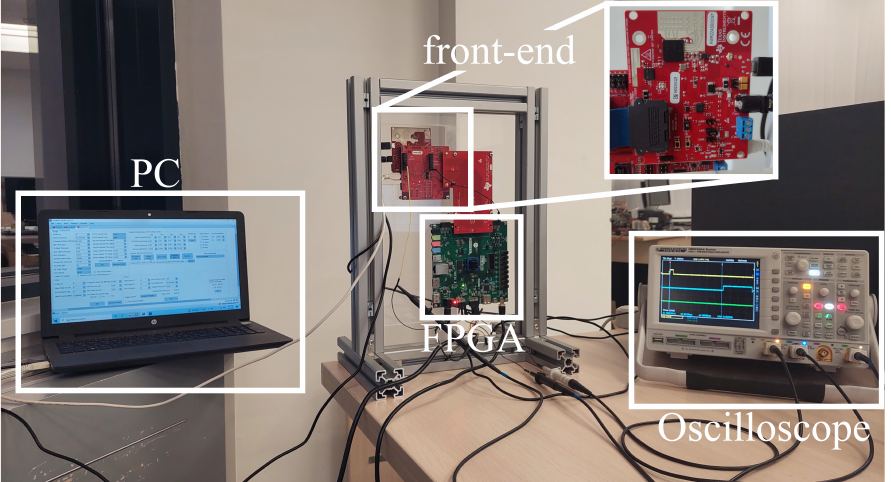
Figure 15. Experiment setup for the latency measurement of the early obstacle detection chain. An oscilloscope is used to measure signals from the FPGA. A hardware trigger signal is connected from the FPGA to the AWR2243 radar front-end in order to control when the AWR2243 will start its processing. A PC is used to configure AWR2243 and to write to the control registers of the design. The AWR2243 evaluation module containing the AWR2243 radar front-end is connected to the FPGA board via FMC connector.